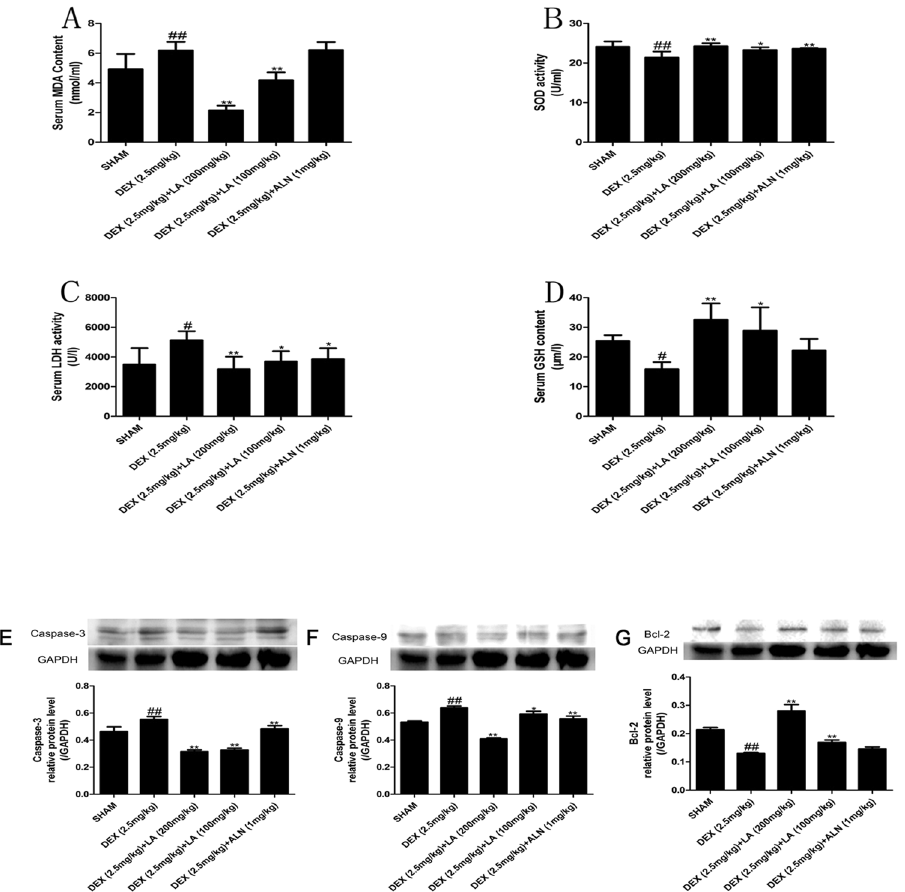
Figure 2. Analysis of the serum oxidant and antioxidant parameters. MDA ( A ), SOD ( B ), LDH ( C ), GSH ( D ). Data were the means ± SD (n = 6 for each group) # . P < 0.05 and ## P < 0.01, vs. the SHAM group. * P < 0.05 and ** P < 0.01, vs. the DEX group. Effect of LA on apoptosis protein (Caspase-3, Caspase-9, Bcl-2) expression on the femur. The protein expression levels of Caspase-3 ( E ), Caspase-9 ( F ), Bcl-2 ( G ) were detected by western blotting. GAPDH was used as the loading control. Data were the means ± SD (n = 6 for each group). ## P < 0.01, vs. the SHAM group. ** P < 0.01, vs. the DEX